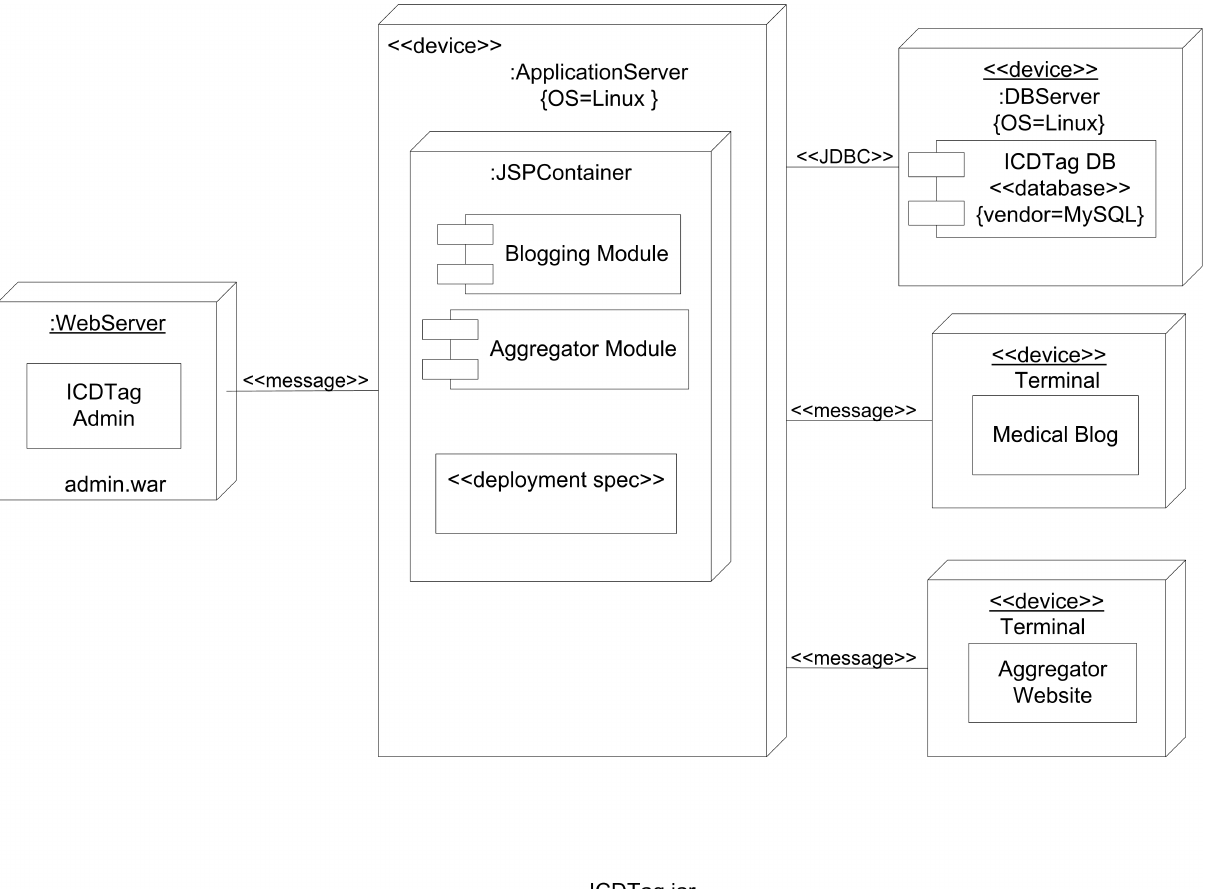
Figure 4. The UML deployment diagram for the ICDTag